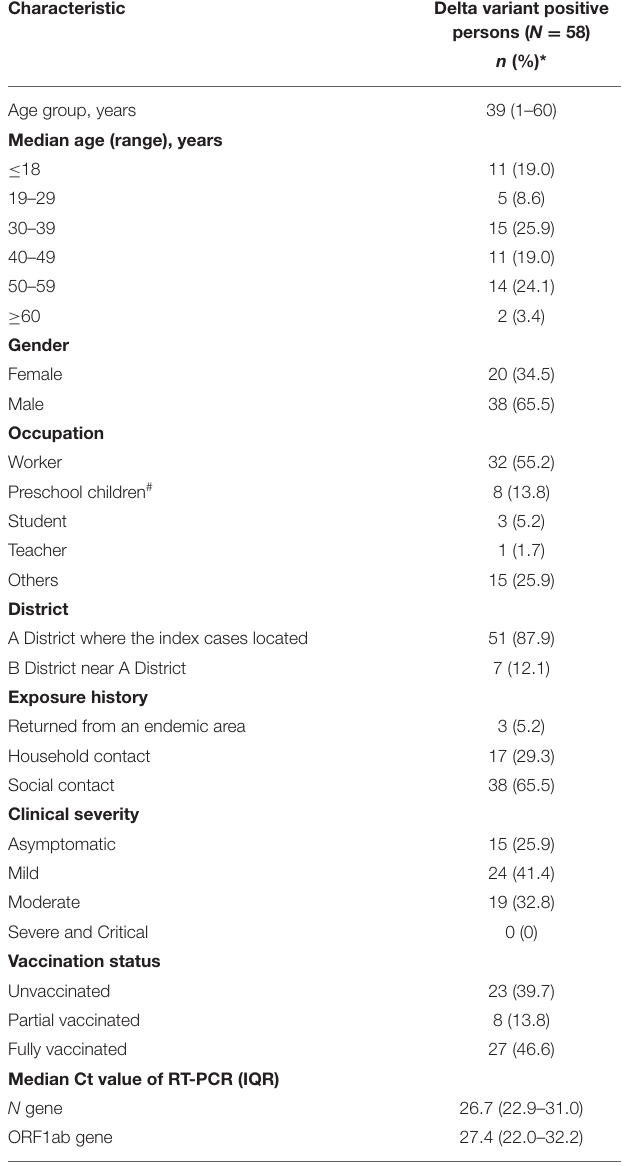
TABLE 2 | Epidemiological characteristics of the SARS-CoV-2 delta variant outbreak in Jingmen City, Hubei Province, China in August 2021. Characteristic